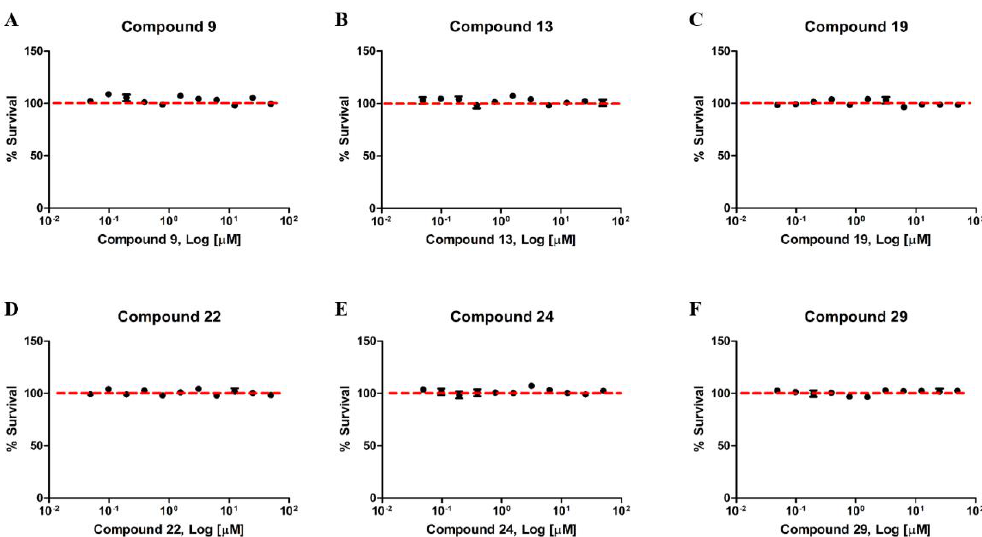
Figure 4. Compounds derived from the 1,2,3-triazole ring have no toxicity in HEK293 cells. Human Embryonic Kidney Cells (HEK293) were treated with different concentrations between 0.0488 µM and 50 µ M of the compounds 9 ( A ), 13 ( B ), 19 ( C ), 22 ( D ), 24 ( E ) and 29 ( F ) for 72 h. The data represent the dose-response curves obtained using the GraphPad Prism software. No treatment resulted in inhibition of cell viability above 80%. Each (N = 3) independent experiment was carried out in triplicate.